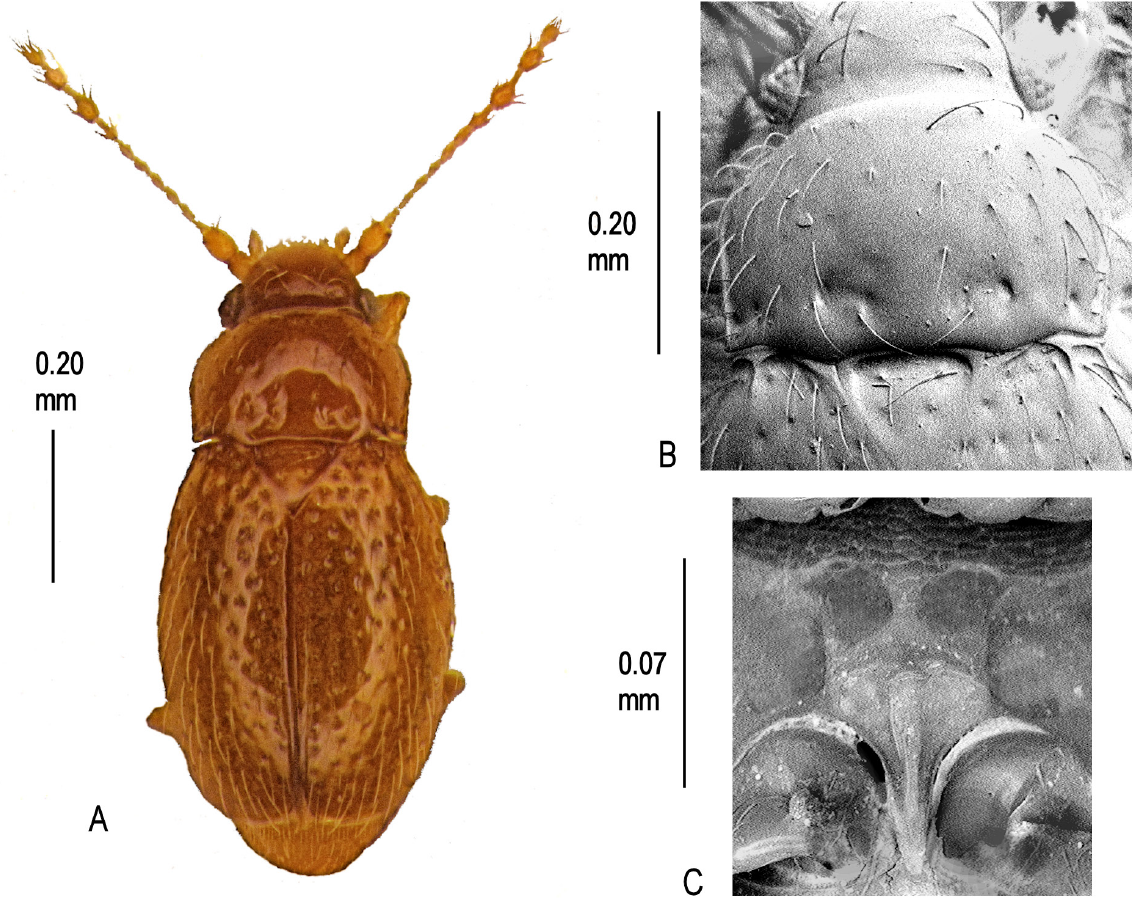
Fig. 27 . Cissidium impressum sp. nov. A . Habitus. B . Pronotum, × 505. C . Mesoventrite showing median process of collar, mid-keel and keel,